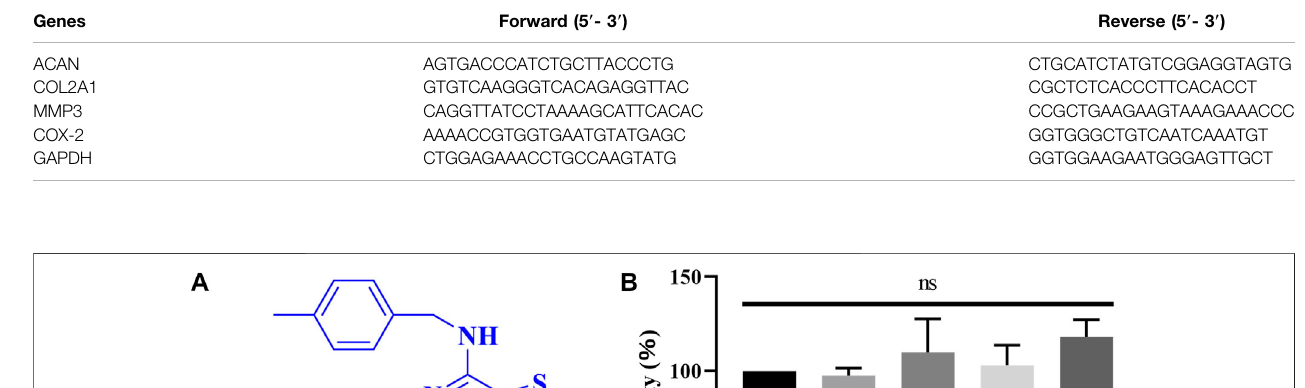
Frontiers in Pharmacology |